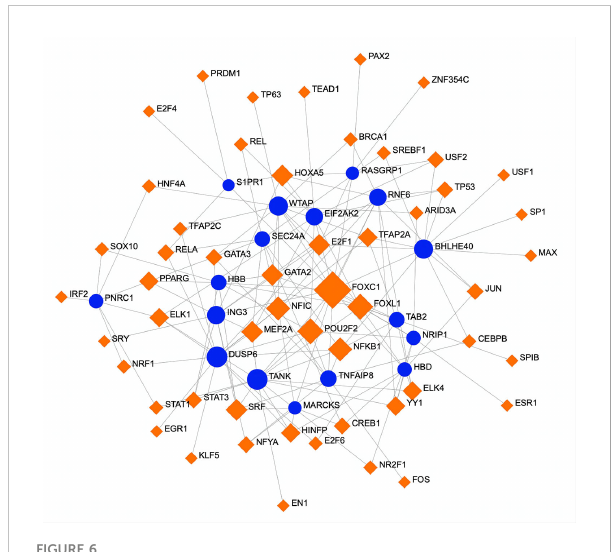
FIGURE 6 A regulatory interaction network of DEG – TFs derived from NetworkAnalyst. Here, the square nodes represent TFs, and gene symbols are circled as they interact with TFs. The larger the square or circle, the more important the TFs or DEGs are in this network. DEG, differentially expressed gene; TFs, transcription